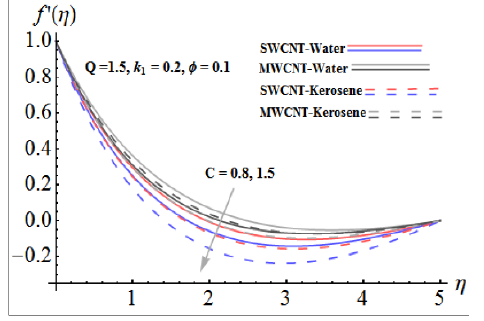
Figure 4. Behavior of f ′ ( η ) for increased values of C .